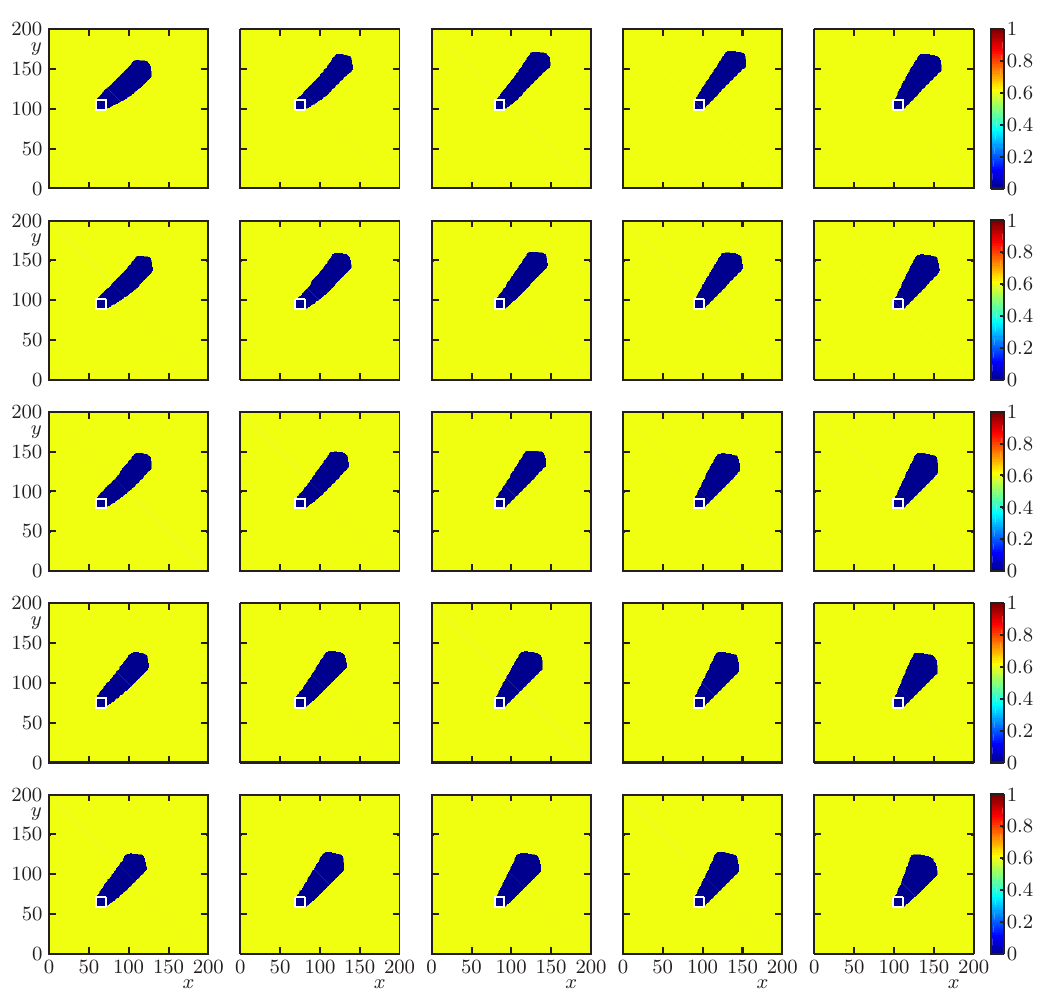
Figure 14. Scenario 3.4: simulation of fuel of a wildfire from 5 small white squares, on a domain with topography